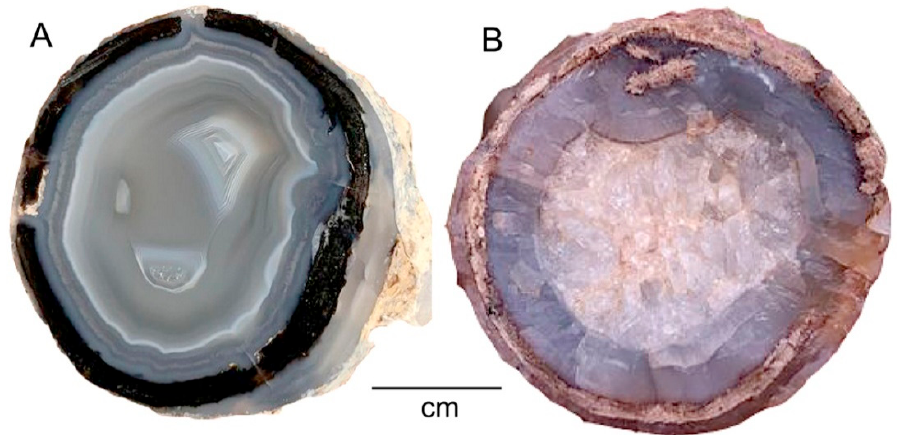
Figure 13. Eocene limb casts from southwestern Wyoming, USA. ( A ) Dark silicified bark surrounds banded chalcedony cast; Big Sandy reservoir locality. ( B ) Dark peripheral zone, inferred to be relict bark, encloses a limb cast, consisting of a thick chalcedony layer and a central area of crystalline quartz; Blue Forest locality.